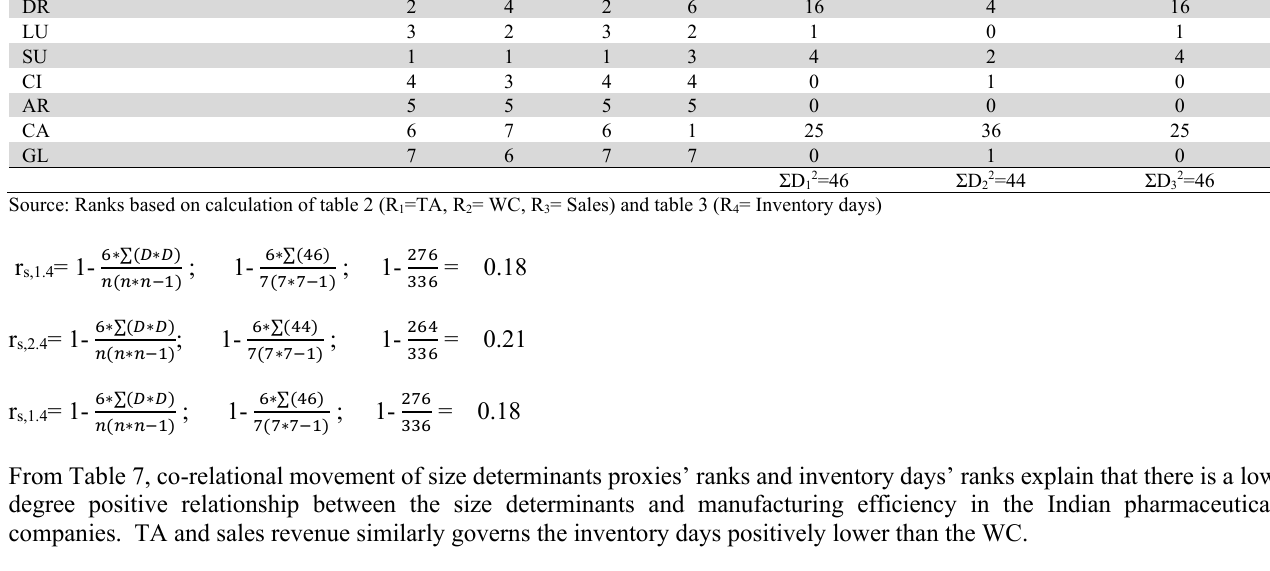
Firms' size determinants and Inventory days relational co-movement Indian Pharm. Companies